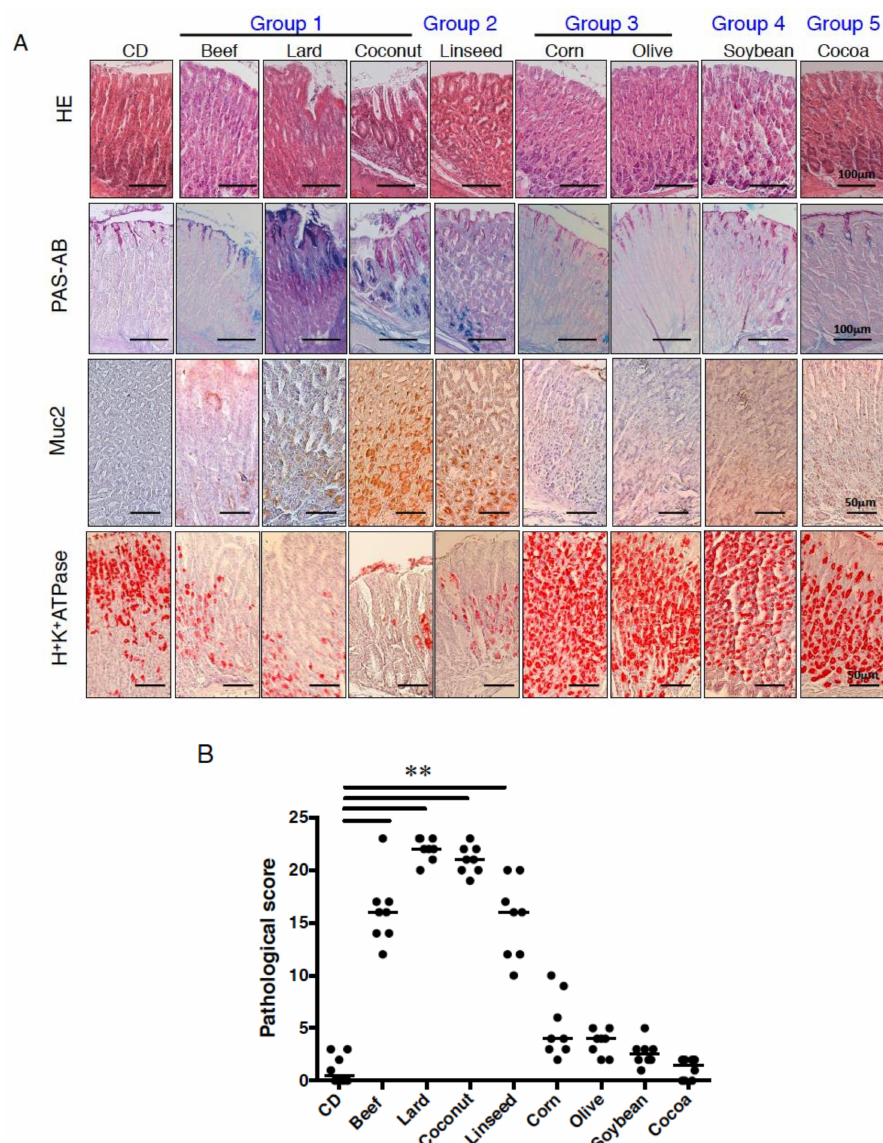
Figure 2. Pathological feature of gastric mucosa owing to various HFDs. ( A ) Gastric sections stained for periodic-acid Schi ff (PAS)-Alcian blue, Muc2, and H + K + ATPase in mice fed experimental diets for 12 weeks. We utilized eight mice in each analysis, and representative data are shown. ( B ) The histological scores from the stomachs of mice fed CD or HFDs were graded according to the diagnostic criteria described in the Methods. Data presented as medians (99.9% confidence intervals) were analyzed by the one-way ANOVA followed by Holm-Sidak post-hoc test for multiple comparisons. ** p < 0.001. Eight mice per group were